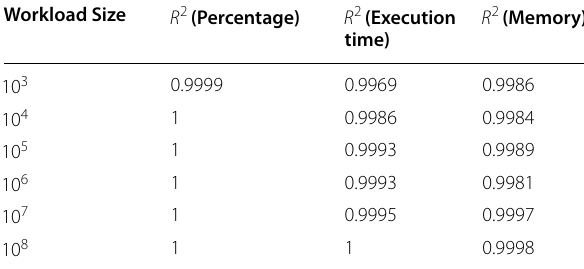
Table 2 Scaling workloads with real users’ behaviour Workload Size